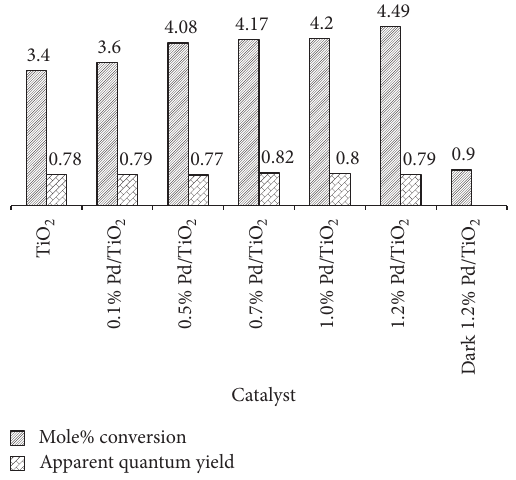
Figure 4: Effect of Pd loading on titania used for solvent- free photo/dark oxidation of toluene. Reaction conditions : toluene: 20 mL, cat: 100mg, temp: 333 K, irradiance: 3hrs, flow: 40 mL/min, pO 2 ; 760 torr, and stirring: 850 rpm.